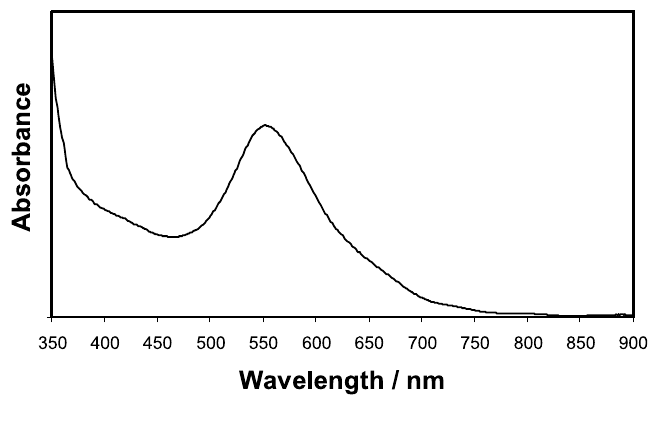
Fig. 1 – Electronic spectrum of a photoanode sensitized by Eugenia jambolana